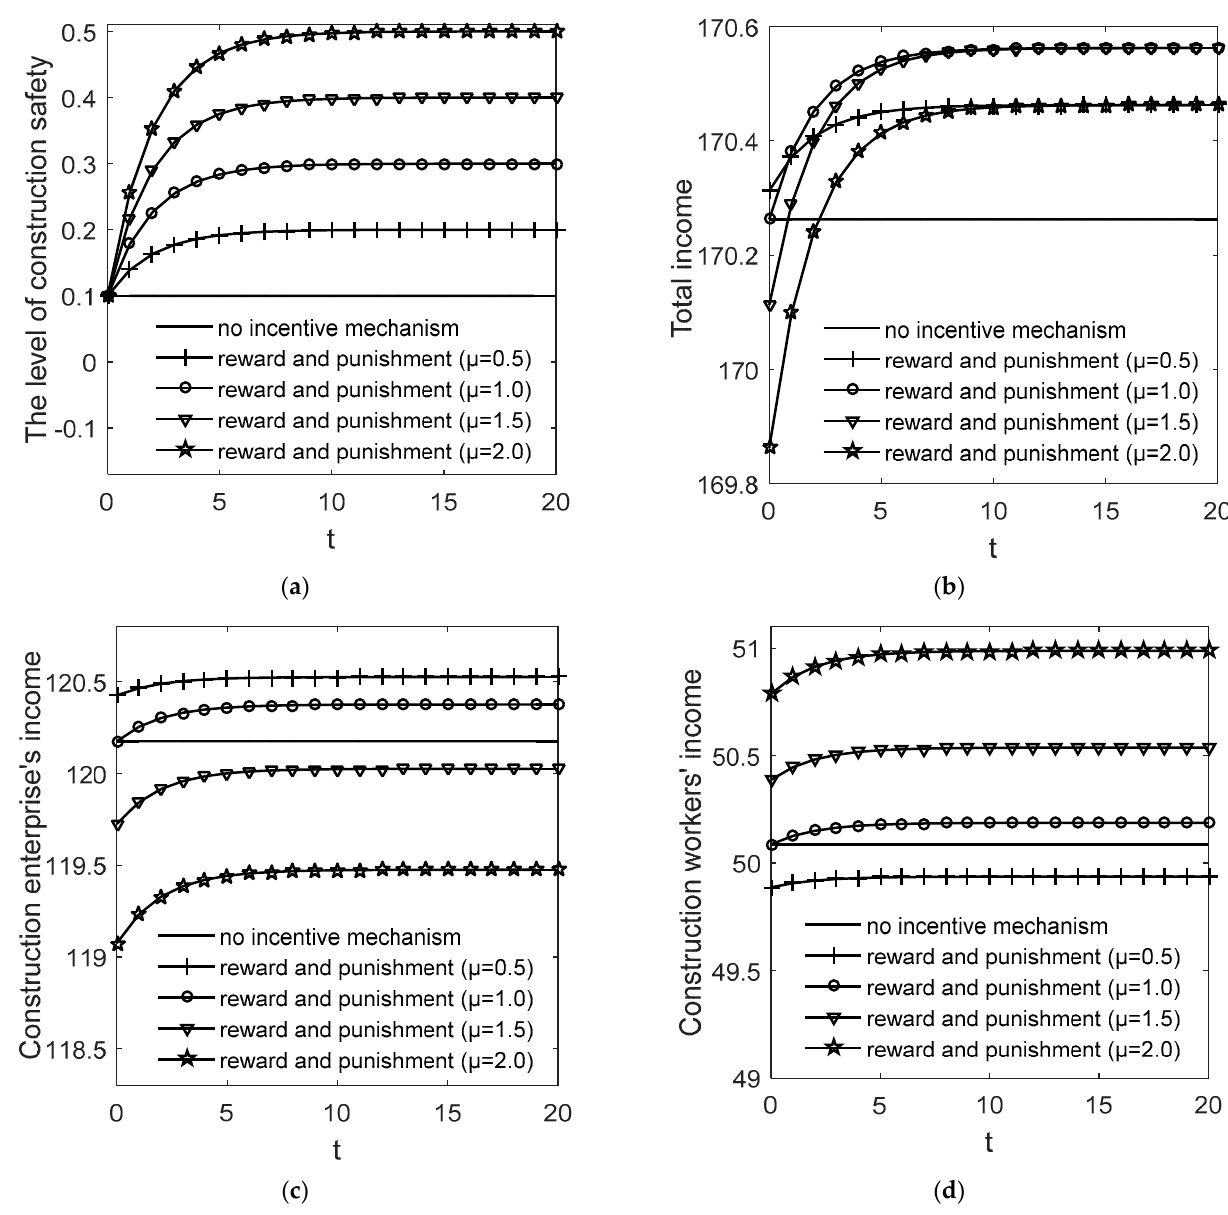
Figure 2. Influence of the reward and punishment mechanism on model results (where 𝐿 = 0.15 ):( a ) The level of construction safety; ( b ) Total income of the construction enterprise and construction workers; ( c ) Construction enterprise’s income; ( d ) Construction workers’ income.